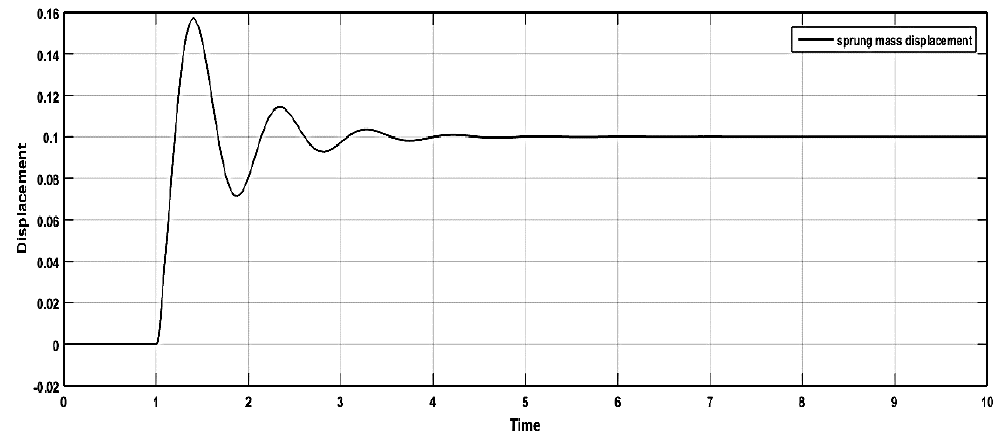
Figure 10. Displacement of the sprung mass Quarter car model